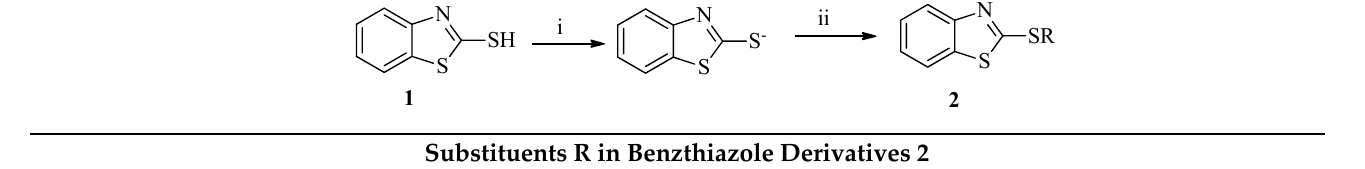
Figure 2. Compounds design based on bibliography [4,5,22,25,26]. 2. Results and